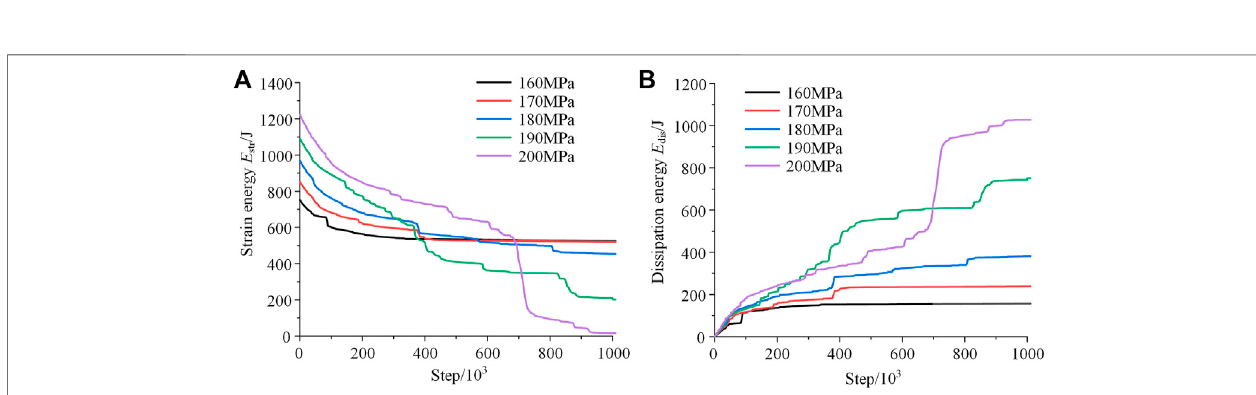
Frontiers in Earth Science |